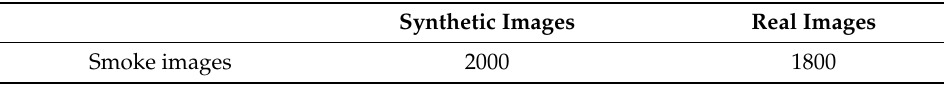
Table 1. Image datasets for pixel-level domain adaptation.